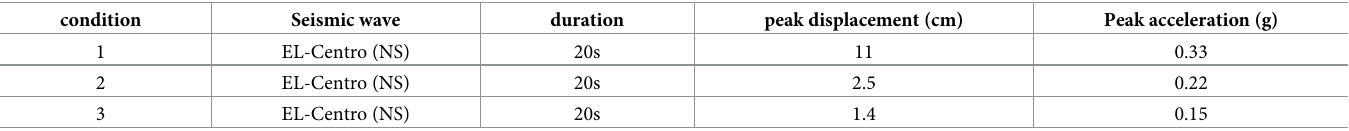
that the recognition method proposed in this paper can be applied to the seismic simulation shaking table in the parameter identification of the matrix system and be used to establish a proper model.